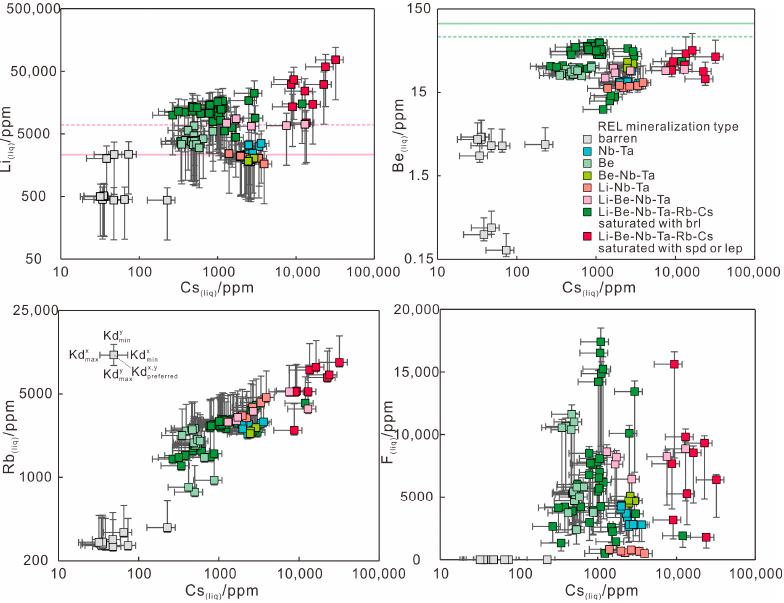
Figure 9. Calculated trace element contents (Li, Be, F and Rb) of liquids at equilibrium with mus- covite from REL pegmatite dykes plotted as a function of the calculated Cs concentration of the liquid. The Koktokay No.3 pegmatite represents the Li-Be-Nb-Ta-Rb-Cs mineralization type and the compositions of muscovites from zones I–IV and V–VIII [45,100] are used for calculating the trace elements content of liquids that are saturated with beryl and spodumene/lepidolite, respectively. The green dashed and solid lines refer to Be contents of liquid saturated with beryl and beryl-bearing pegmatite [111]. The pink dashed and solid lines indicate Li contents of liquid saturated with Li-aluminosilicate and spodumene-bearing pegmatite